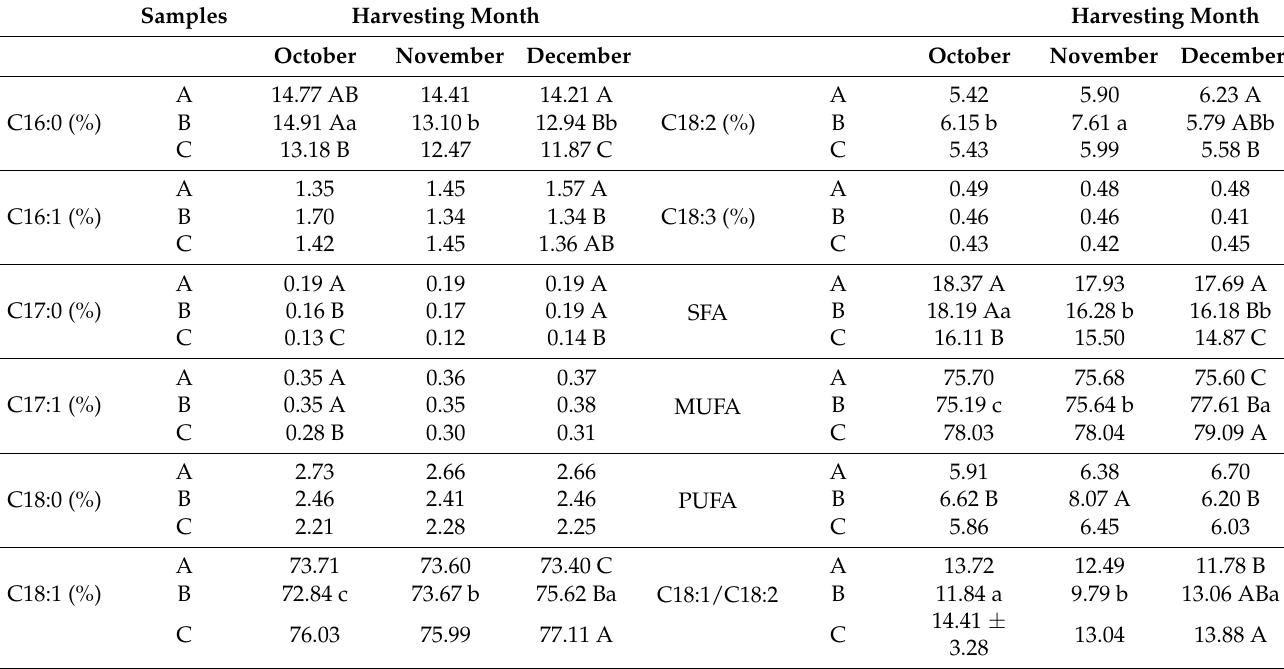
Table 2. Fatty acid composition of olive oils extracted from drupes produced from trees grown in three sites (A, B, and C). Samples